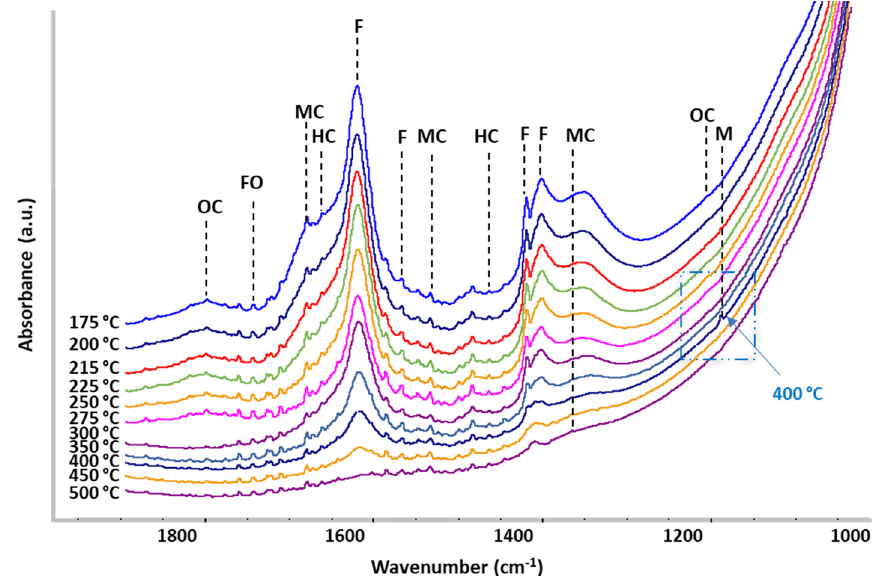
Figure 7. Operando FTIR spectra for CO 2 methanation over the Ni/Al catalyst. Species identification: HC (hydrogen carbonate), MC (monodentate carbonate), BC (bidentate carbonate), OC (organic carbon), F (formate), M (methoxy), FO (formaldehyde).